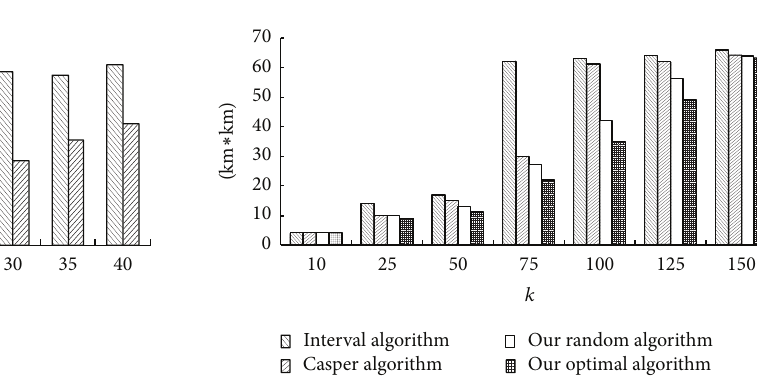
Algorithm 2: Random ASR.